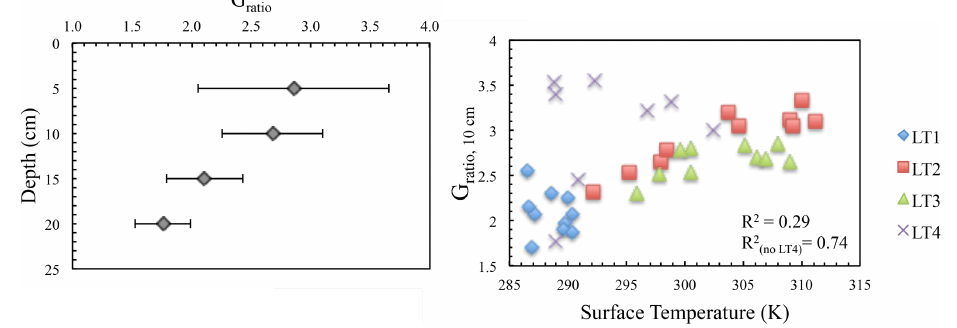
Figure 5. G ratio as a function of depth (left) and corresponding G ratio values at 10cm depth for each sensor (right). Table 2. Modeled results for the nonlinear sloped and flat model in the focus area with the high-resolution DEM showing trends in debris thickness ( d ), surface temperature ( T s ), and net radiation ( R n ) with respect to slope and aspect. Topographic parameter Sloped model (focus area) Flat model (focus area) Average d (m) Average T s (K) Average R n (Wm − 2 ) Average d (m) Average T s (K) Average R n (Wm − 2 ) 0–5 0.17 Slope